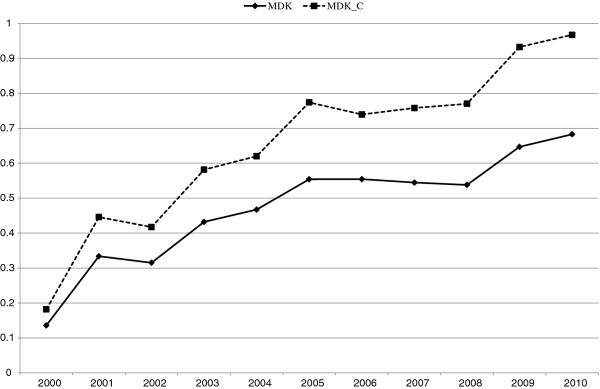
Trend of MDK and MDKCfor Medical Services.